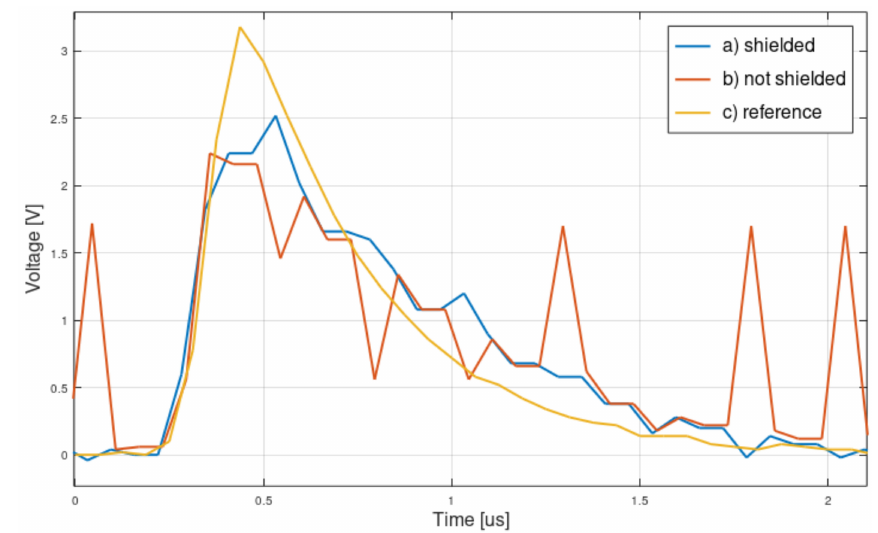
Figure 6. Impulses with and without shielding.